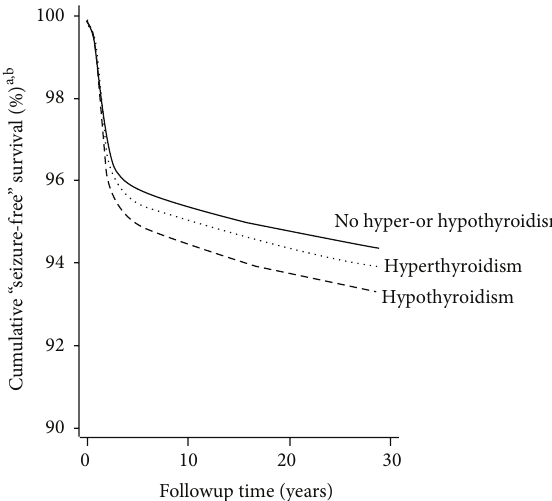
Figure 2: First-time diagnosis of maternal thyroid dysfunction in relation to birth of firstborn child. The figure illustrates number of firstborn singleton live births per year with a first-time diagnosis of maternal hyper- or hypothyroidism registered in the Danish National-Hospital Register (DNHR) during the pregnancy (during) and in 1 year intervals before/after the pregnancy (1st, 2nd, 3rd, etc.). a Firstborn refers to primiparous mother. Firstborn singleton live births with missing information on gestational age or registration of gestational age < 20 or > 45 weeks not included ( 𝑛 = 30,363). Number of singleton live births with maternal diagnosis during the pregnancy estimated per year.